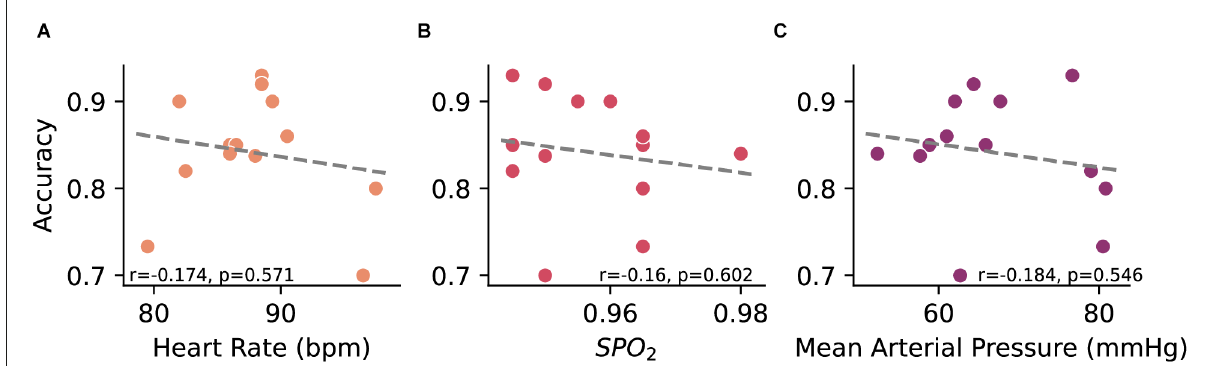
FIGURE4 Relationship between online decoder accuracy and measured (A) heart rate, (B) pulse oximetry, and (C) mean arterial pressure. Each point represents a closed-loop data session where the accuracy is an average across all trials and the cardiovascular metrics is the average of pre- and post-session measurements. Linear regression between the variables was performed using Pearson’s product-moment